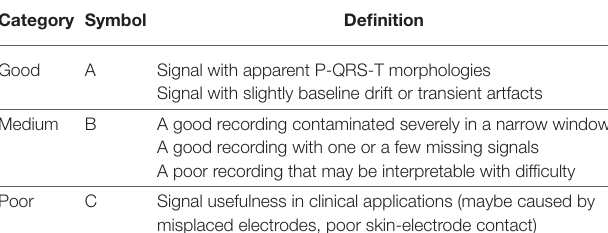
TABLE 2 | Specification for signal quality division (Shen et al., 2020). Category